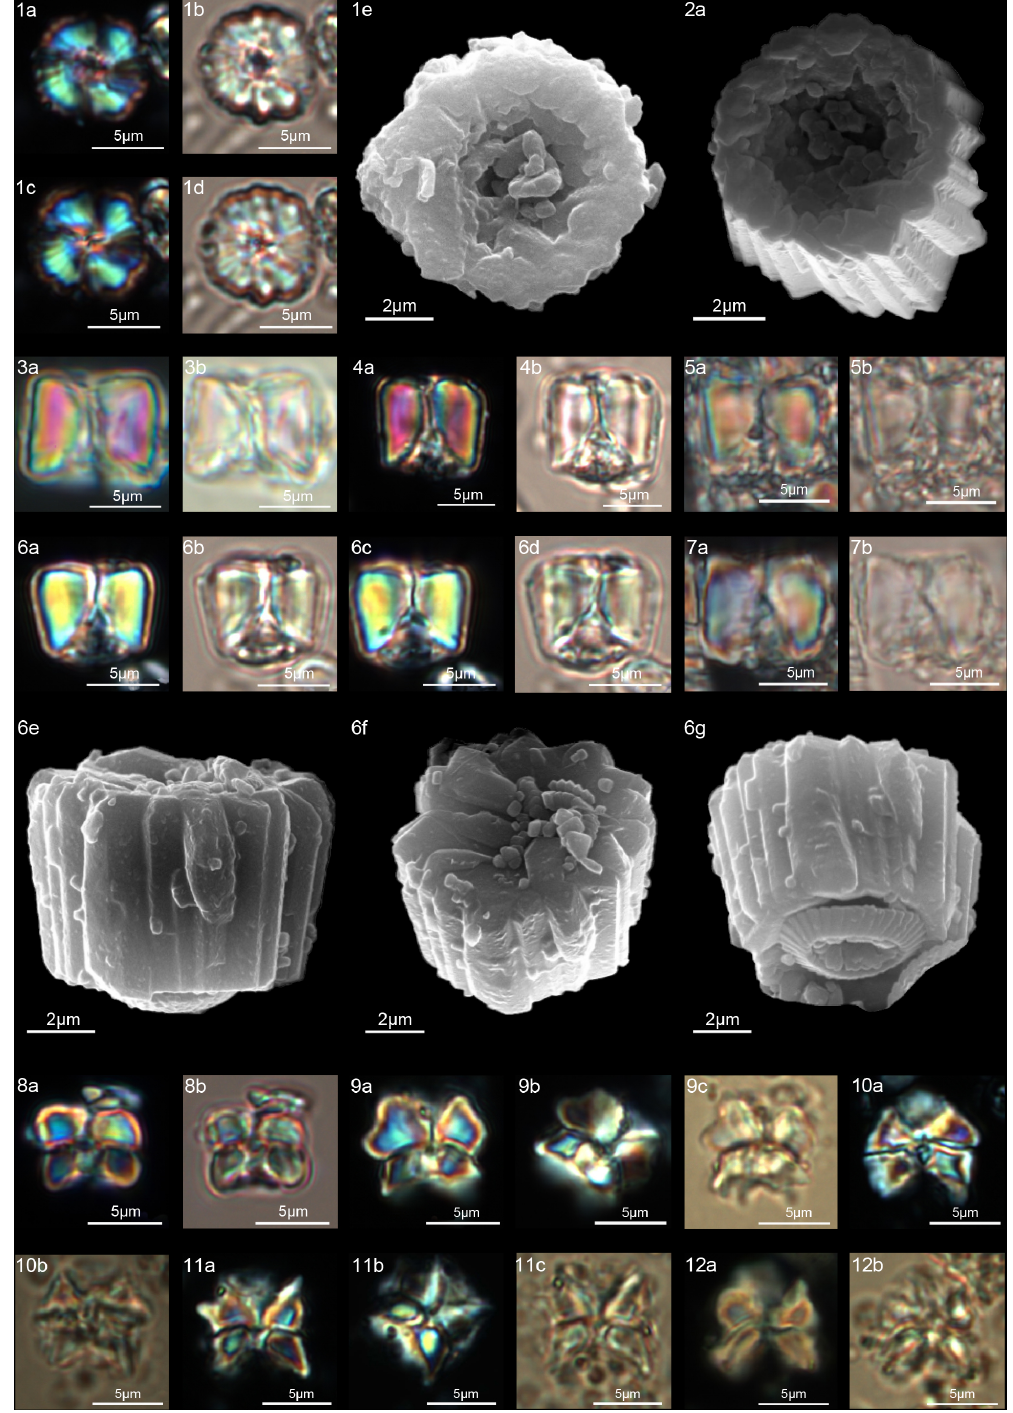
Figure 9. Gomphiolithus magnus . (1) Sample: 1209B 25-1, 142–143; views of proximal side. (1a–c) XPL, (1b, d) PPL, (1e) SEM. (2) Sam- ple: 1262C 11-5, 131–132. (2a) SEM view of proximal side. Gomphiolithus magnicordis . (3) Sample: 1209B 25-2, 20–21. (3a) XPL, (3b) PPL. (4) Sample: 1209B 25-1, 142–143. (4a) XPL, (4b) PPL. (5) Sample: Bottaccione 11.14m. (5a) XPL, (5b) PPL. (6) Sample: 1209B 25-1, 142–143. (6a, c) XPL, (6b, d) PPL, (6e) SEM side view, (6f) SEM distal view, (6g) SEM proximal view. (7) Sample: Con- tessa Highway 10.07m (above the K–Pg boundary). (7a) XPL, (7b) PPL. Diantholitha cf. D. mariposa. (8) Sample: 1209C 14-1, 116–117. (8a) XPL, (8b) PPL. (9) Sample: Qreiya + 7.1m. (9a, b) XPL, (9c) PPL. (10) Sample: Qreiya + 7.1m. (10a) XPL, (10b) PPL. Diantholitha mariposa . (11) Sample: Qreiya + 7.7m. (11a, b) XPL. (11c) PPL. (12) Sample: Qreiya + 9.42m. (12a) XPL, (12b) PPL. See Table S1 for sample